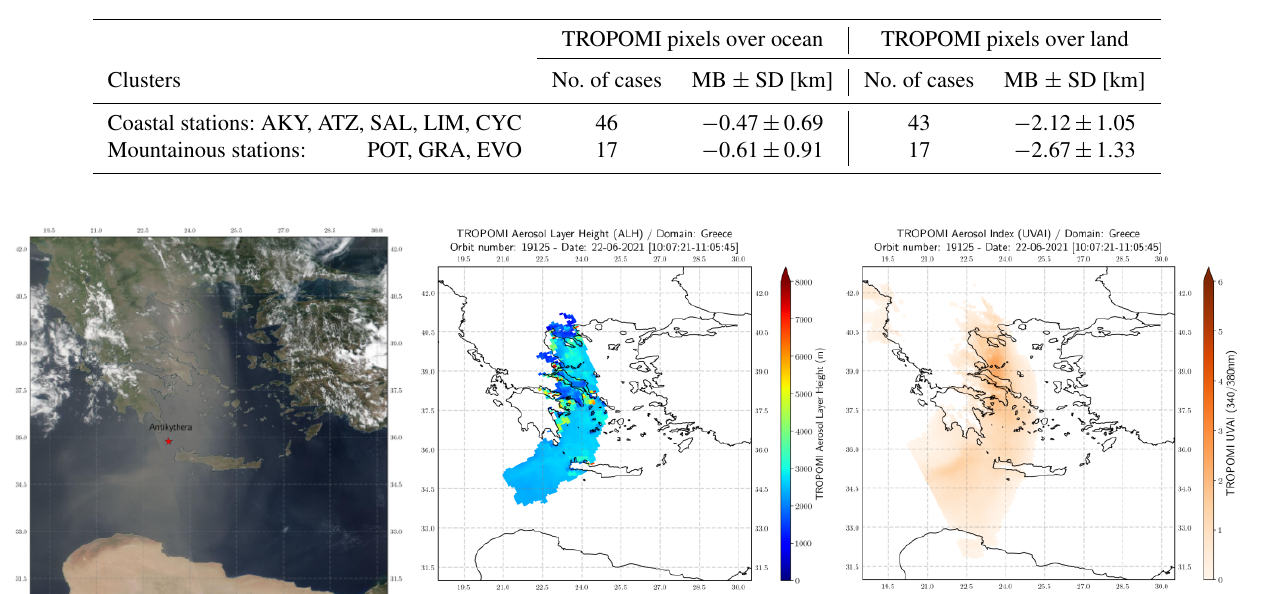
Table 5. Clustering of EARLINET stations with respect to topographical features and the corresponded TROPOMI-EARLINET mean bias. Details about the EARLINET stations are provided in Table 1.